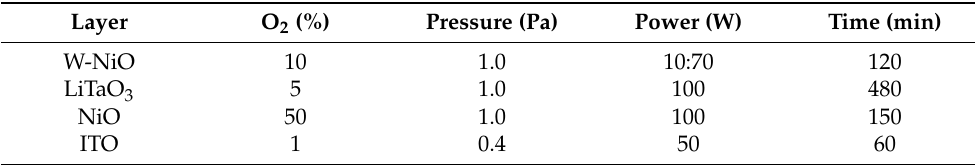
Table 1. Deposition parameters for the layers in the all-solid-state ECDs. Layer O 2 (%) Pressure (Pa) Power